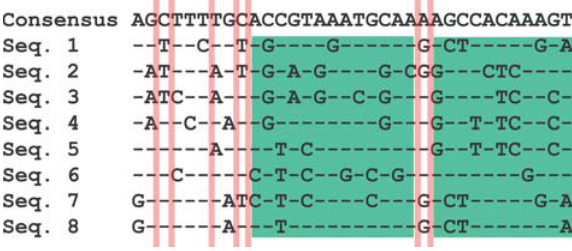
Figure 1. A Hypothetical Example of Eight Aligned Haplotypes for All the SNPs Found in a Region Base positions that are not variable are not shown. Blocks of adjacent SNPs that revealed no evidence of historical recombination are fl anked by vertical red bars. Two longer haplotype blocks are indicated in green. The presence of historical recombination was discerned by the four-gamete criterion. In brief, if the haplotypes for two SNPs, each with two bases (e.g., A/G at one SNP and C/T at the second), reveal all four possible combinations (i.e., A-C, A-T, G- C, and G-T) then this is evidence that there has been a recombination event between these SNPs in the history of the sample of haplotypes (Hudson and Kaplan 1985). If haplotype blocks are long, then it is possible to represent much of the haplotype diversity using just a small sample of the SNPs found within that